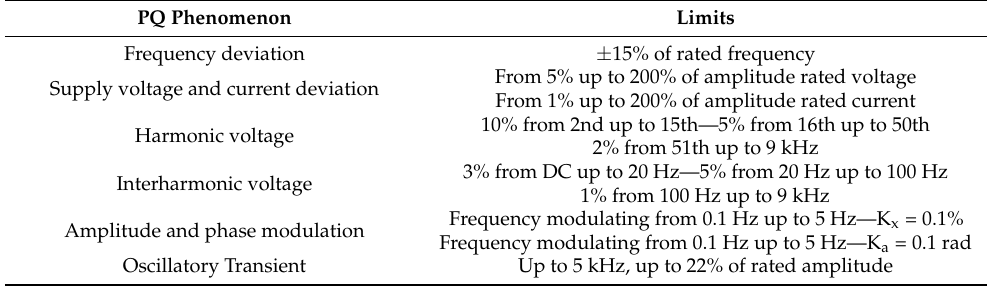
Table 1. Maximum limit of PQ phenomena from the literature and